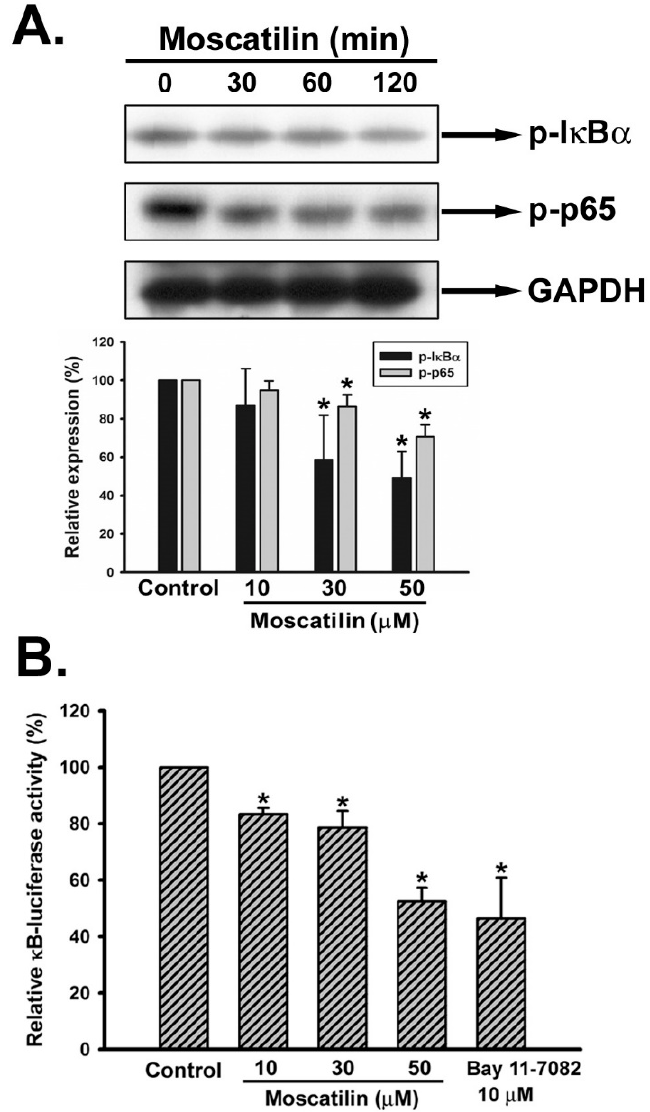
Figure 5. Effect of moscatilin on NF- κ B pathway in human HCC cells. ( A ) SK-Hep-1 cells were treated with moscatilin (30 µ M) for the indicated time intervals, and p-I κ B α and p-p65 were determined by Western blot analysis. The quantitative densitometry of the relative level of protein was performed with Image-Pro Plus. ( B ) SK-Hep-1 cells cotransfected with pNF- κ B-Luc and phRG-TK vector were treated with the indicated concentration of moscatilin or BAY 11-7082 for 12 h, and the promoter luciferase activities were detected using a luminometer. Data are expressed as means ± S.E.M. of four independent experiments. * p < 0.05 compared with the control group.